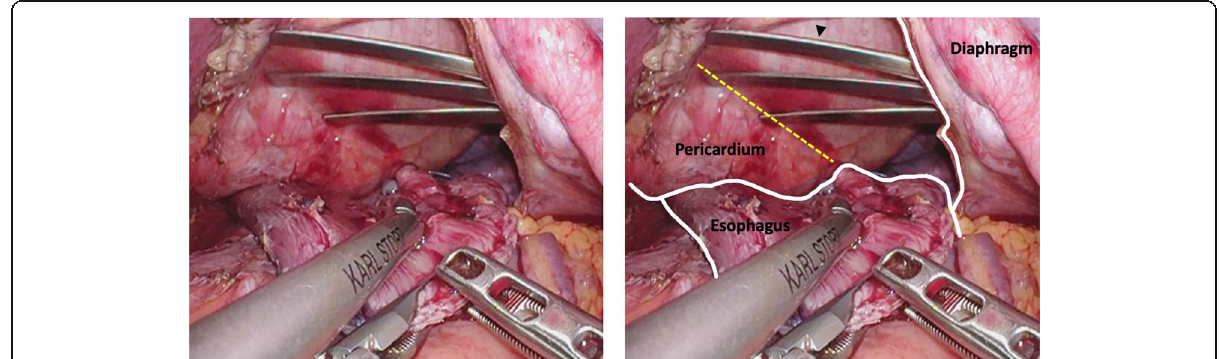
Fig. 2 Intraoperative laparoscopic findings at the beginning of esophagogastric anastomosis. The left diaphragm is incised, and the pericardium is lifted up by the retractor (indicated by the arrowhead) to expose the surgical field. The retractor blade is placed close to the posterior interventricular sulcus (indicated by yellow dotted